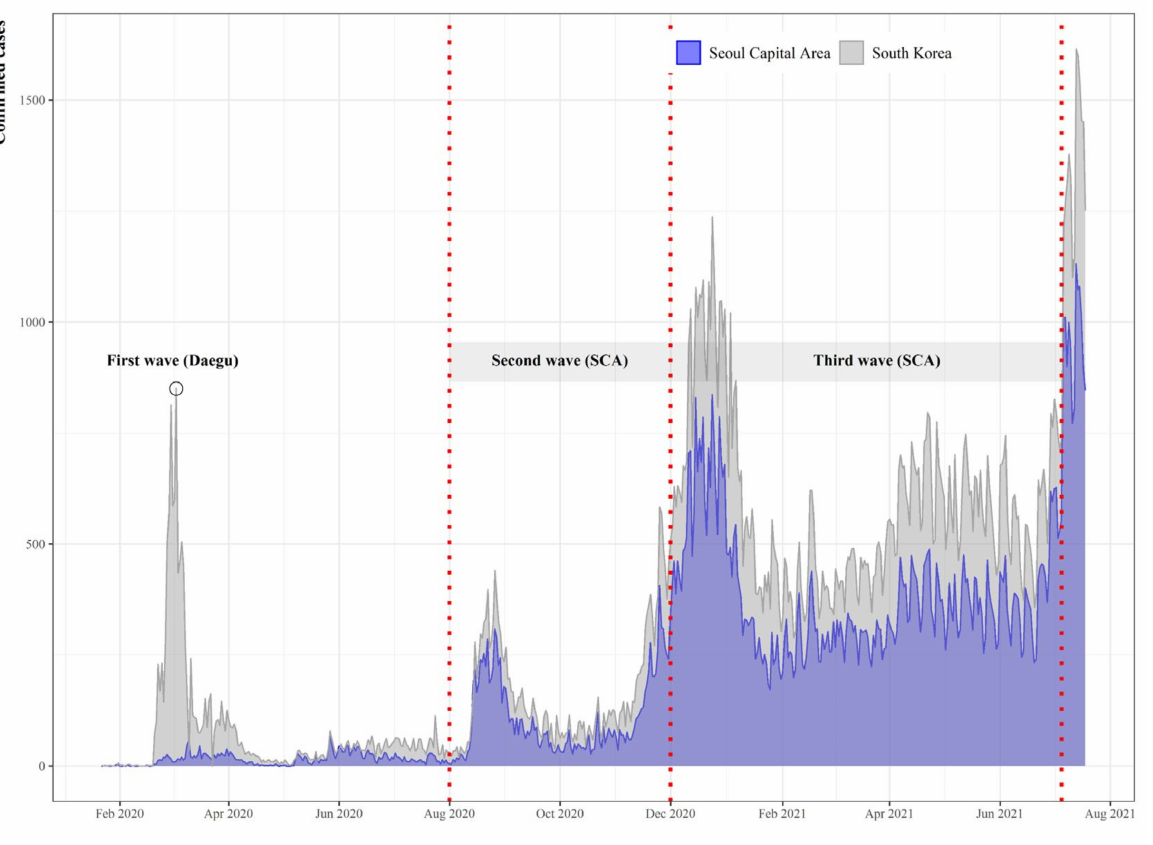
Figure 1. Daily confirmed cases of